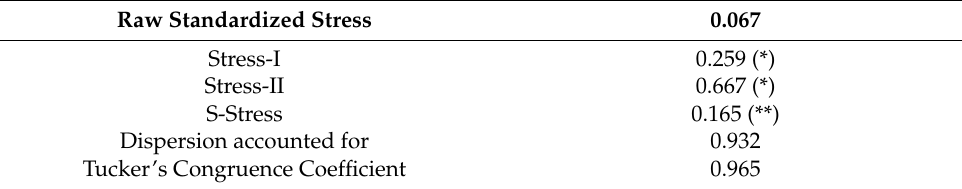
Table 2. Wellness-of-fit measutes of the multidimensional scaling model.